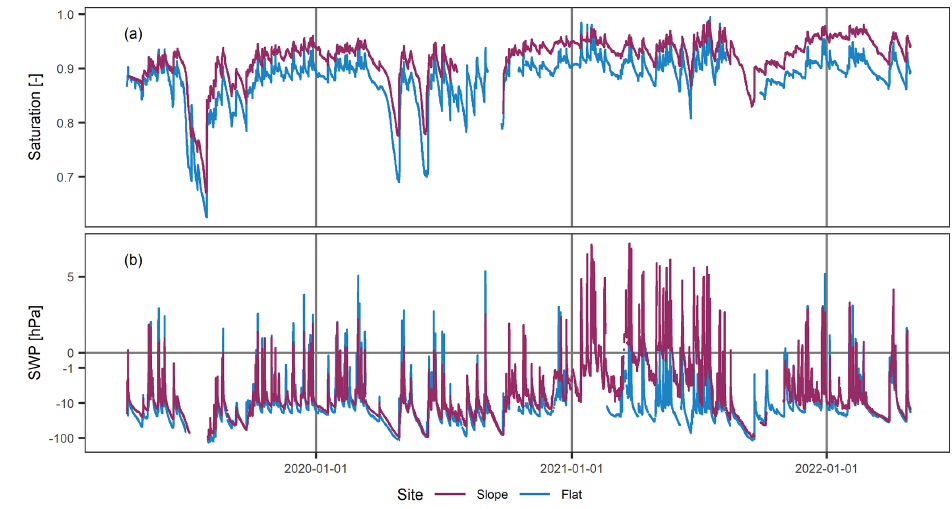
Figure 5. Hourly profile mean saturation (a) and SWP (b) over the entire study period for the flat and the sloped site.